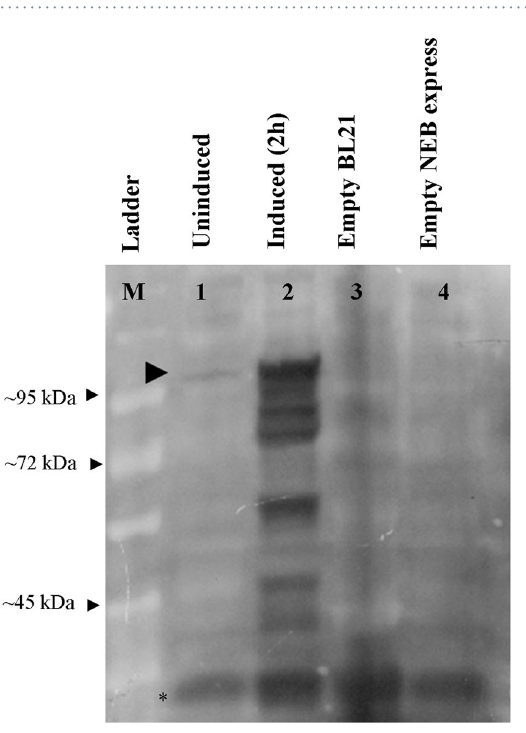
Figure 1. Western blot analysis done using lab raised antibodies, showing cleavage of full length fusion protein during induction. Lane M contains prestained protein ladder, Lane 1 contains uninduced cells, basal expression of full-length protein is marked with an arrow, Lane 3 contains total protein from 2 hr induced sample, full- length protein along with number of degraded products are visible. Lane 3 and 4 contains total proteins from wild type BL21 DE3 and NEB express cells. No cross reactivity with total proteins from wild type strains was observed. The low molecular bands observed (marked with * ) at the bottom of western blot represent the non- specific bands observed in all